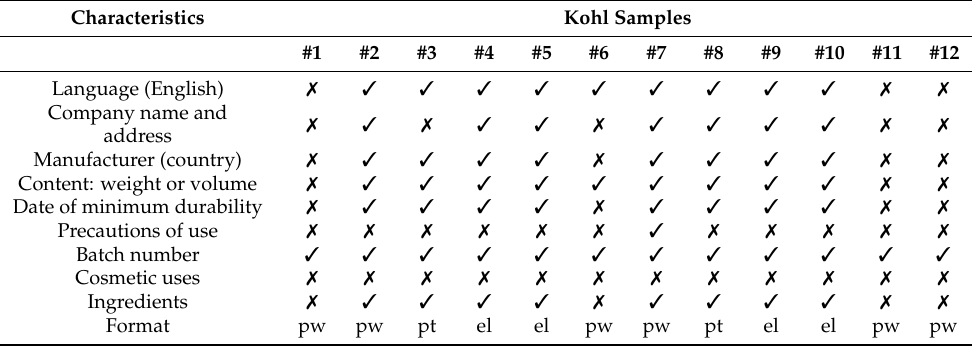
Table 3. Checklist of the labeling in the analyzed kohl samples following the recommendations of Regulation 1223/2009, article 19 of the EU. S: Spain; G: Germany; pw : powder; pt : paste; el : eyeliner. Characteristics